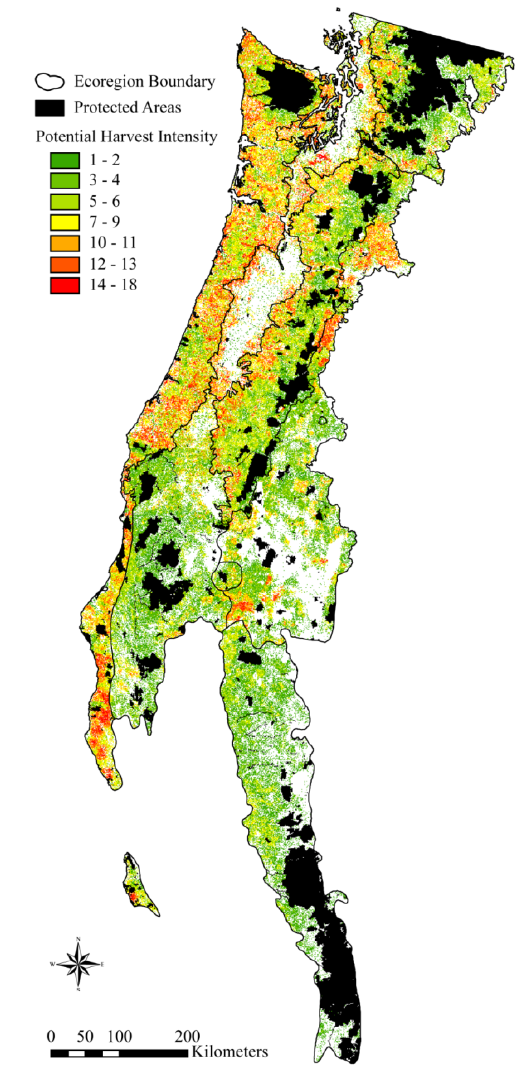
Figure 5. Potential forest harvest intensity in the Pacific Northwest from 2000 to 2100. Values from 1 to 18 represent the cumulative number of times a forested pixel was projected to be harvested across all seven scenarios. Ecoregion boundaries are shown and protected areas are indicated in